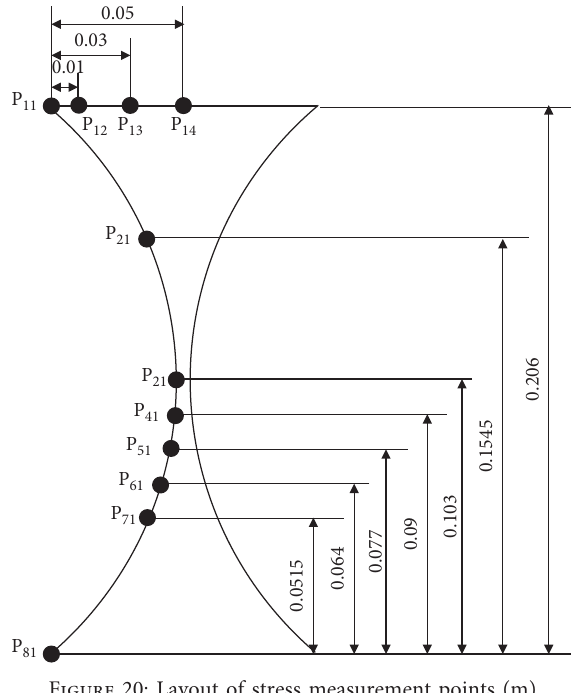
Figure 20: Layout of stress measurement points (m).